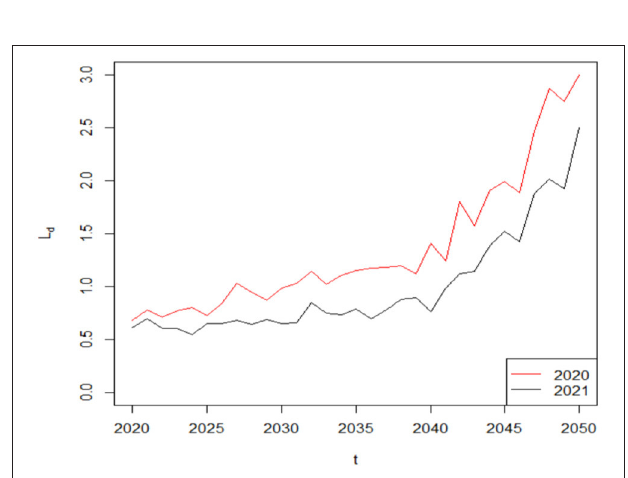
FIGURE 4 | (A) Simulated force of mortality from COVID-19 pandemic and pre-COVID-19 period.